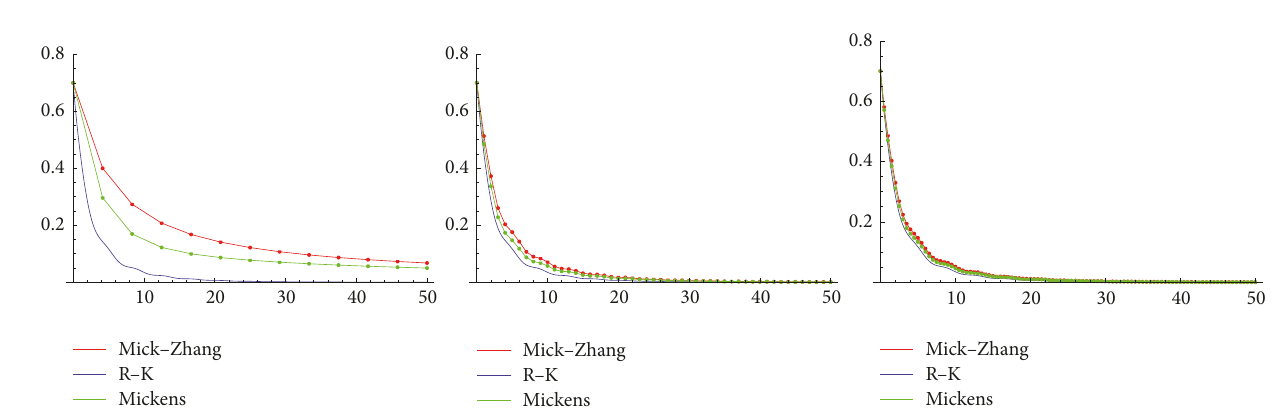
Figure 2: 𝑆𝐼 ; 𝜙(ℎ) = ℎ + 0.2ℎ 2 ; step-size: 4 , 1 , 0.5